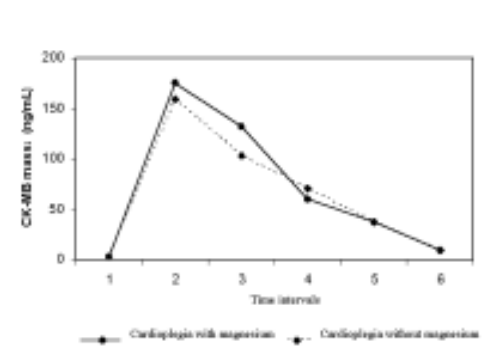
Fig. 4 - Mean values of CK-MB mass (ng/mL) according to the time intervals and the cardioplegia used.